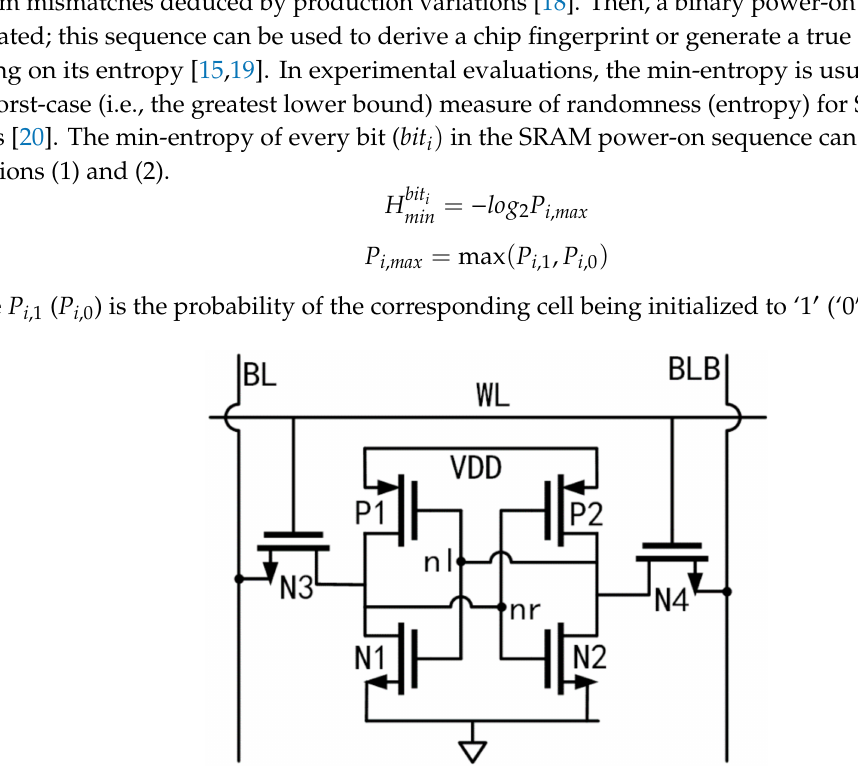
Figure 1. Schematic of a six-transistor (6-T) static random-access memory (SRAM)